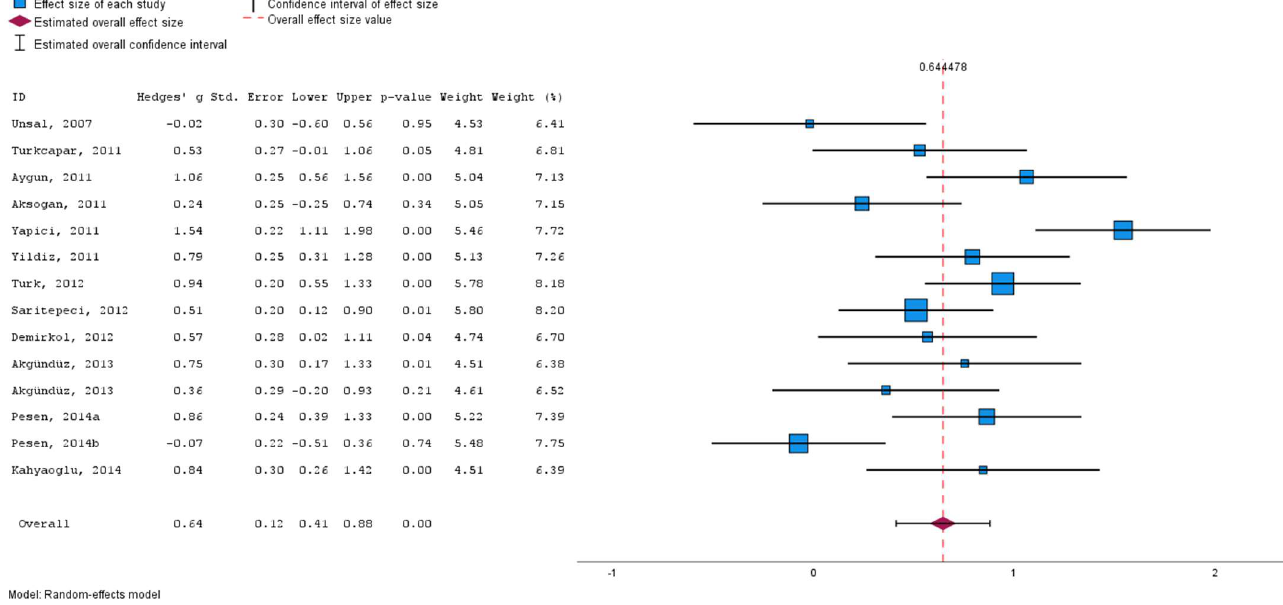
Table 3. Sample data set for binary meta-analysis [52].